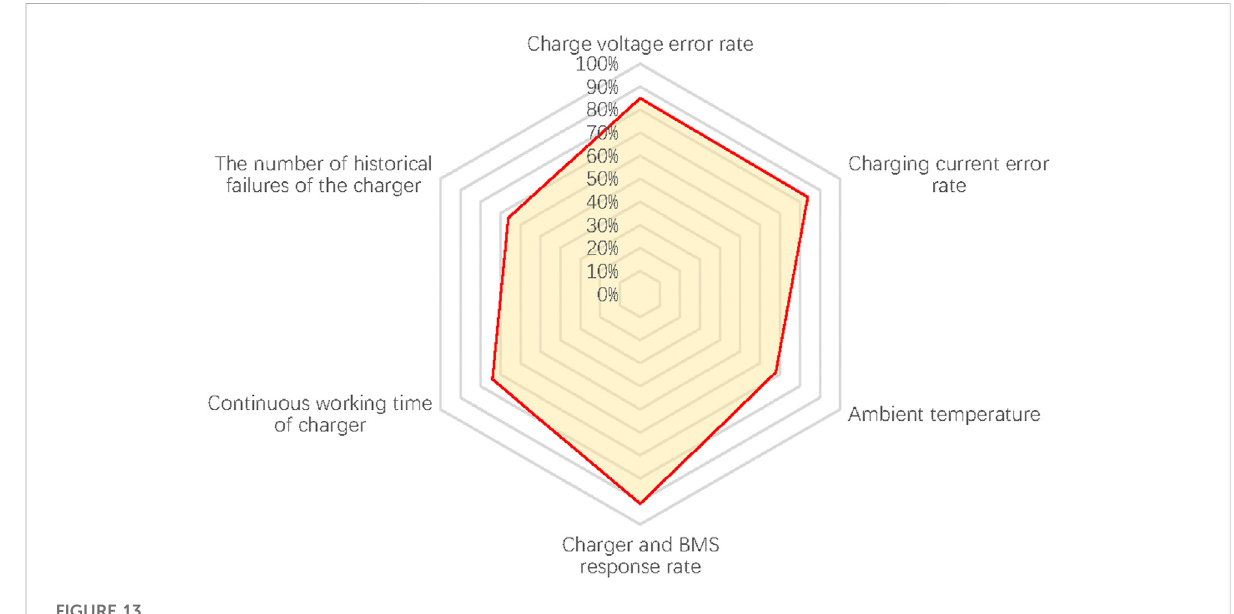
FIGURE 13 Correlation level of DC charger failure factors.